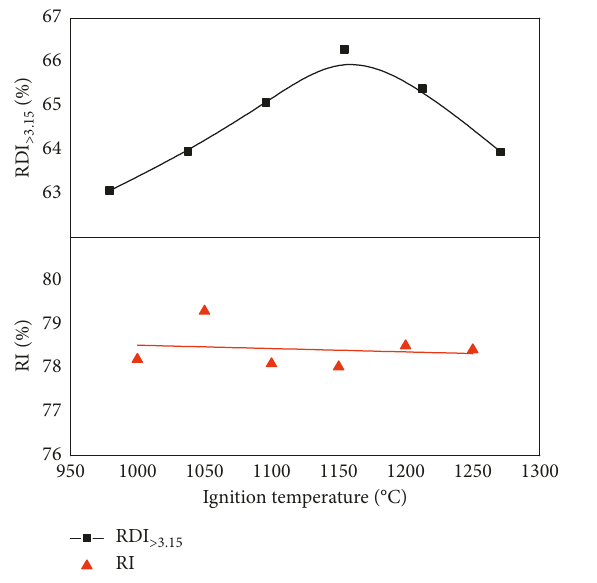
Figure 7: Sintered ore reductivity and RDI temperatures.